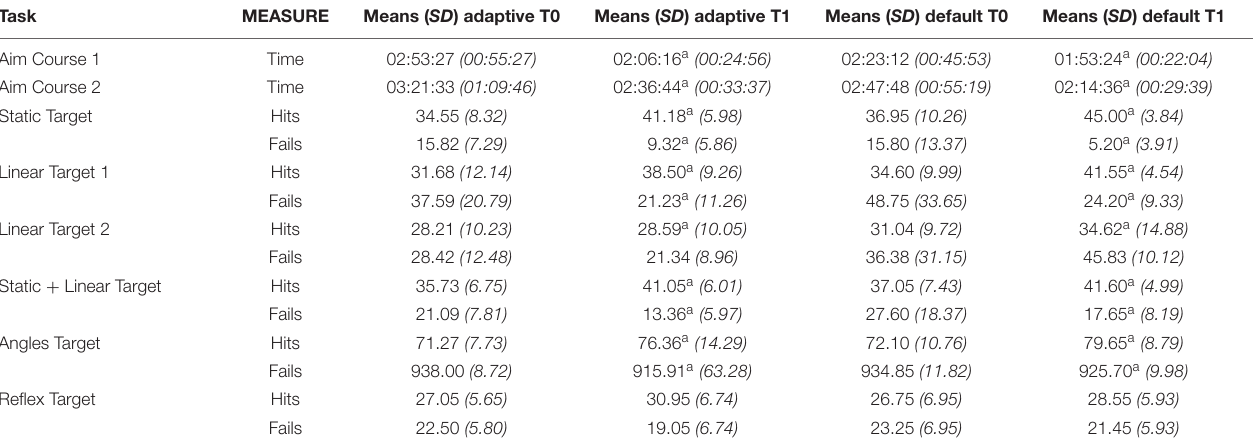
TABLE 1 | Group Means and Standard Deviation (SD) for the pre (T0) and post (T1) game